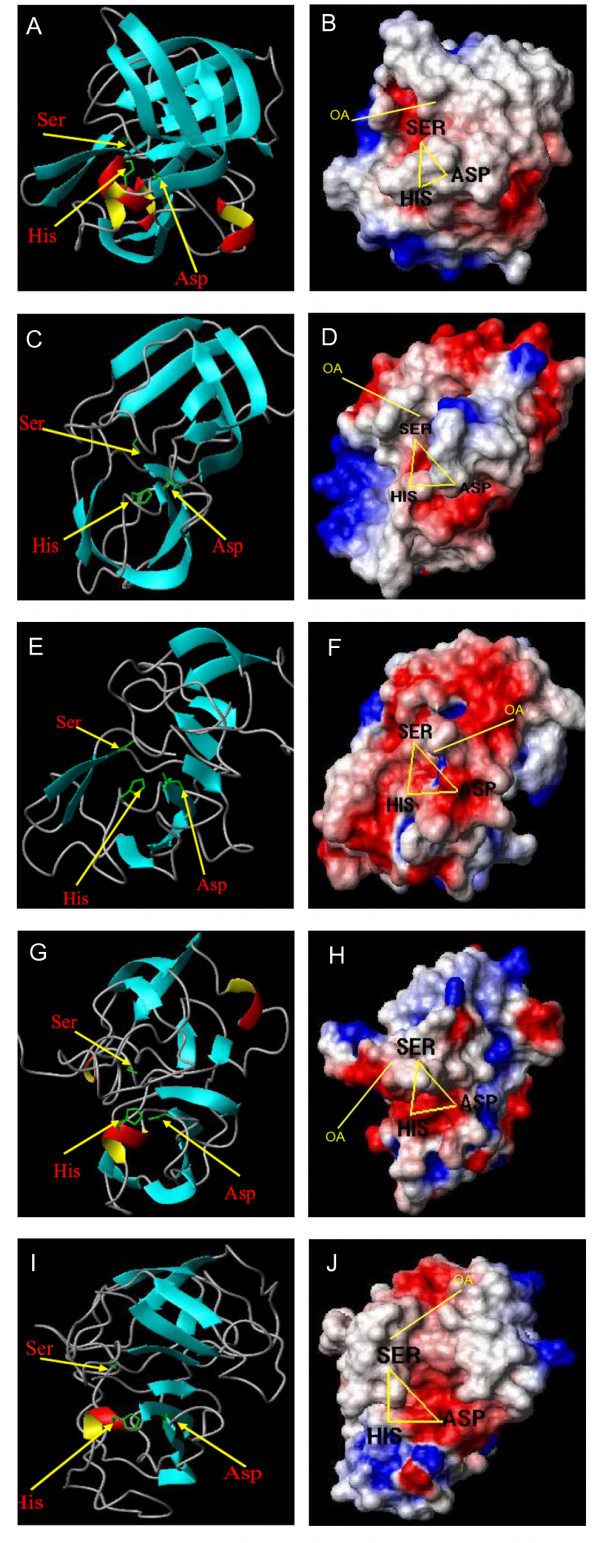
A representative X-ray PA protease structure fromStreptomyces griseusand modeled PA protease structures fromPlasmodium falciparum, Pyrococcus furiosus, Neurospora crassa and Arabidopsis thaliana. Ribbon models of S. griseus, 1SGC (A), P. falciparum (C), P. furiosus (E), N. crassa (G) and A. thaliana (I) PA protease structures show β-sheets with an arrow directed to the C-terminus (light blue), α-helices (red and yellow), turn/loops (gray), and catalytic triad residue side chains (green sticks). Surface electrostatic potential model of S. griseus, 1SGC (B), P. falciparum (D), P. furiosus (F), N. crassa (H) and A. thaliana (J) PA protease structures show electronegative (red), electropositive (blue) and electroneutral (white) amino acid side chains. The estimated position of the oxyanion hole (OA) is also indicated.